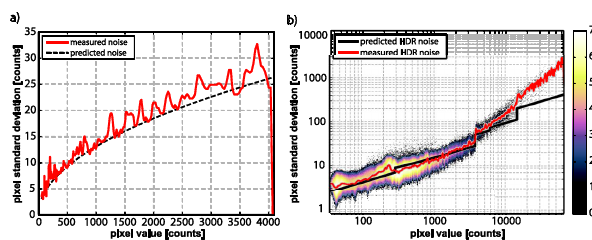
Figure 10. Photon transfer curve for a USI system for (a) a 12- Fig. 10. Photon transfer curve for a USI system for (a) a 12-bit image, and (b) an 3 bit image, and (b) an HDR image. The theoretical minimum shot HDR image. The theoretical minimum shot noise limit is shown as a black line, and 4 noise limit is shown as a black line, and the median of the noise the median of the noise distribution at each count value is shown in red. In (b), the 5 distribution at each count value is shown in red. In (b) , the density of density of the pixel standard deviation distribution is shown behind the curves. 6 the pixel standard deviation distribution is shown behind the